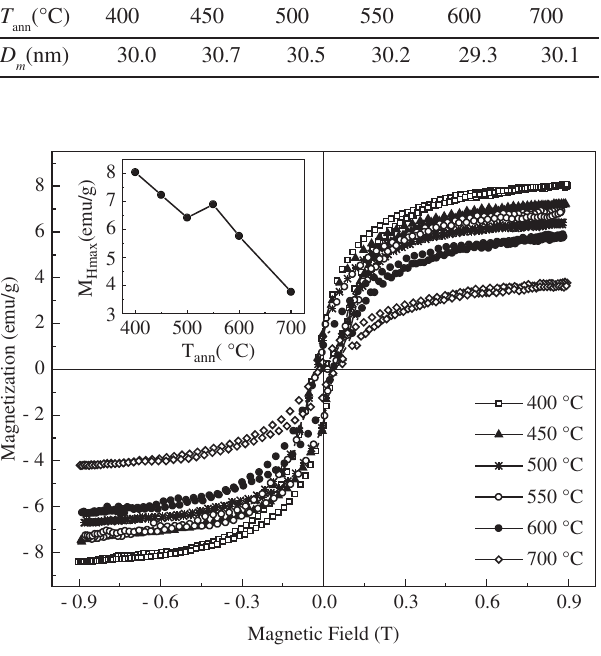
Figure 3. Room temperature hysteresis curves of the Fe Ag 10 90 samples for different annealing temperature. Insert: maximum field magneti- zation as a function of T ann